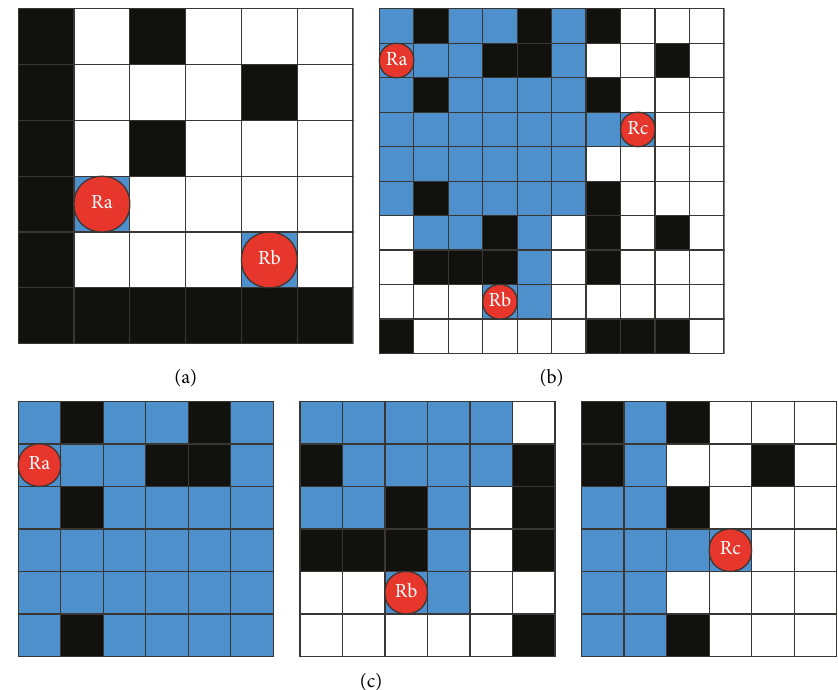
Figure 9: Different sizes of target environment and process ways. (a) Smaller environment than training size. (b) Wider environment than training size. (c) The sliding views for each robot.